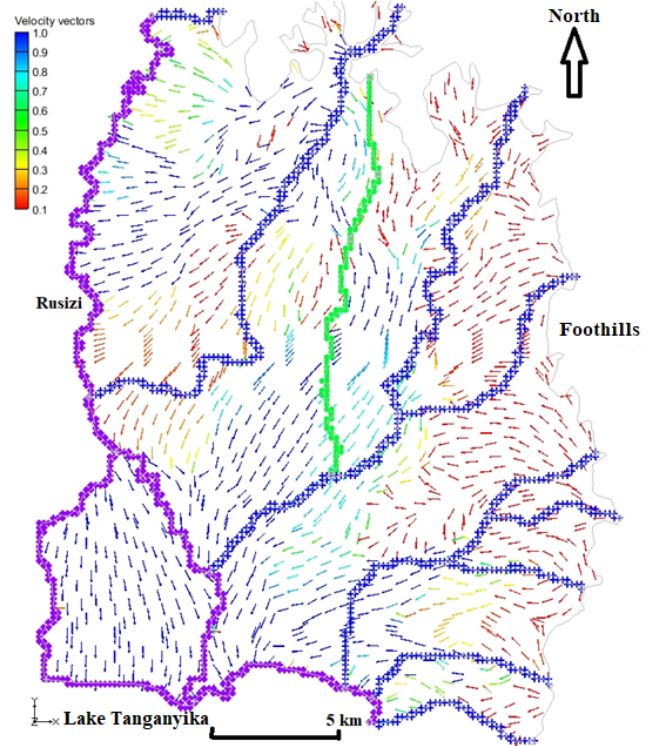
Figure 11. Map showing the computed intensity of the groundwater flux vectors. Table 5. Optimized conductance (C) and computed flux (Q) through the different portions of the rivers represented within the model (+: aquifer drains river; − : river drains aquifer). River C (m 2 /s)